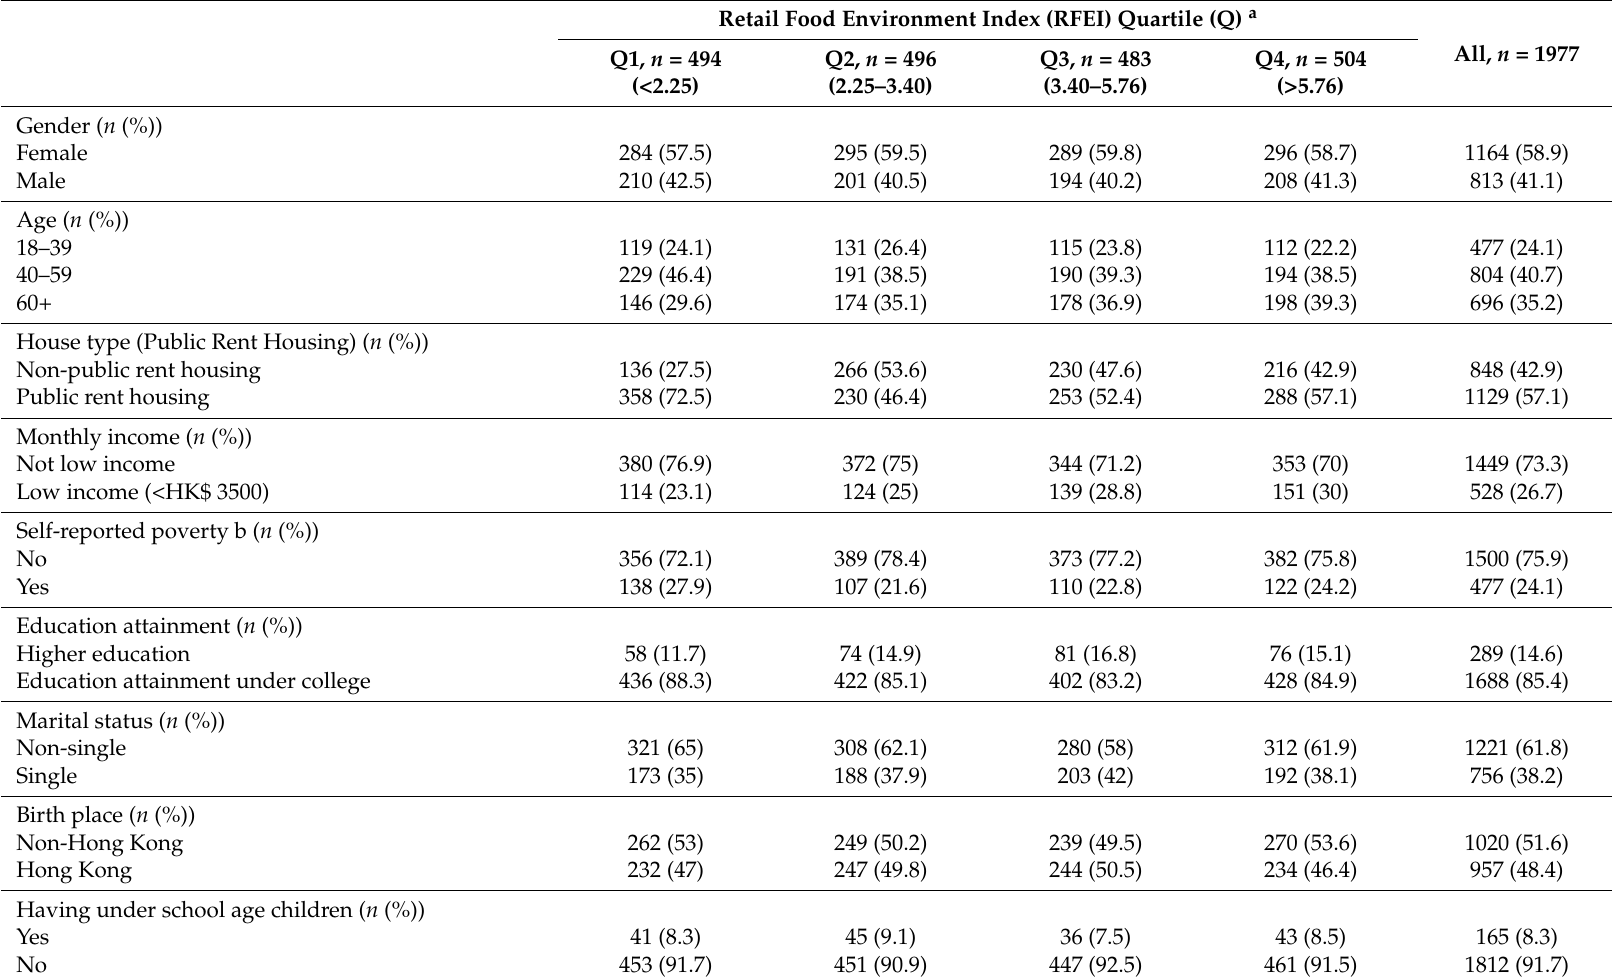
Table 2. Characteristics of the study sample ( n = 1977) by Retail Food Environment Index (RFEI)